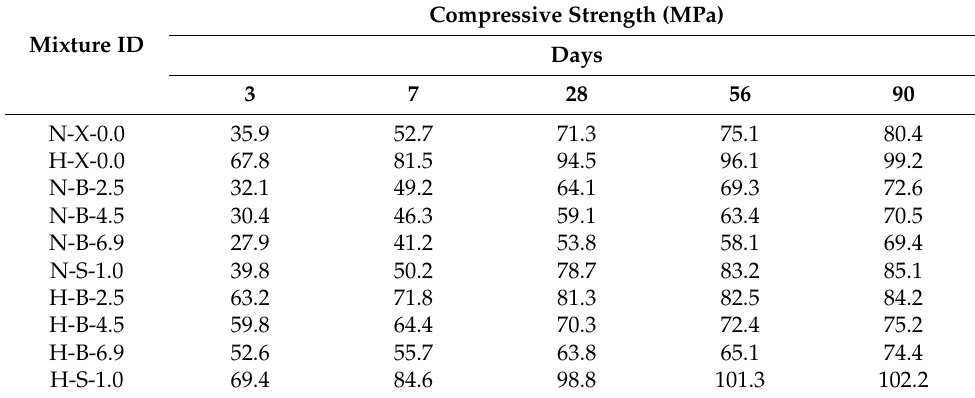
Table 5. Compressive strength results for all